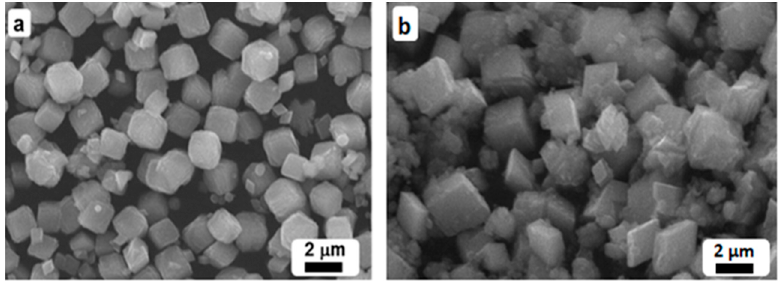
Figure 5. SEM micrographs of (a) (1%)ZrO x –MnCO 3 and (b) (1%)ZrO x –MnCO 3 /(1%)GRO.